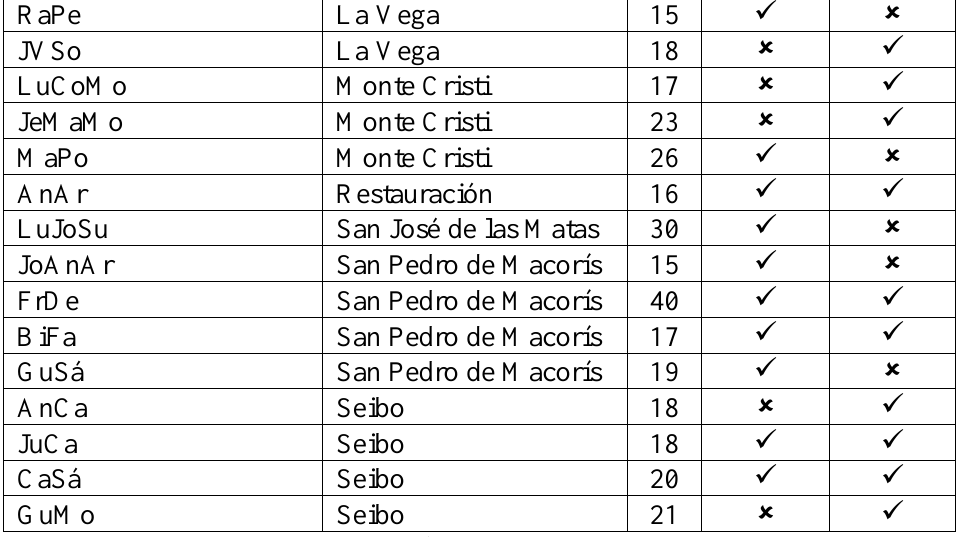
Table (12): Informants employing tú and/or usted in direct non-cleft argumental wh -